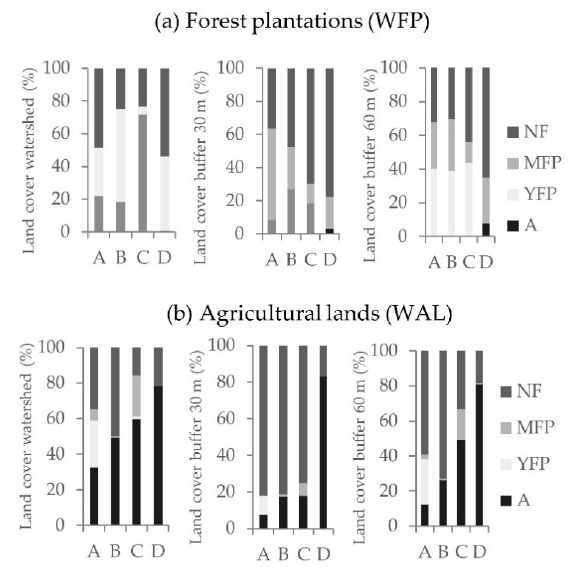
Figure 3. Land cover of NF: Native forest; MFP: Mature forest plantation; YFP: Young forest plantation; and A: Agricultural land; in the entire watershed, and in 30 and 60-meter wide buffer strips for watersheds dominated by ( a ) forest plantations (WFP) and ( b ) agricultural lands (WAL).